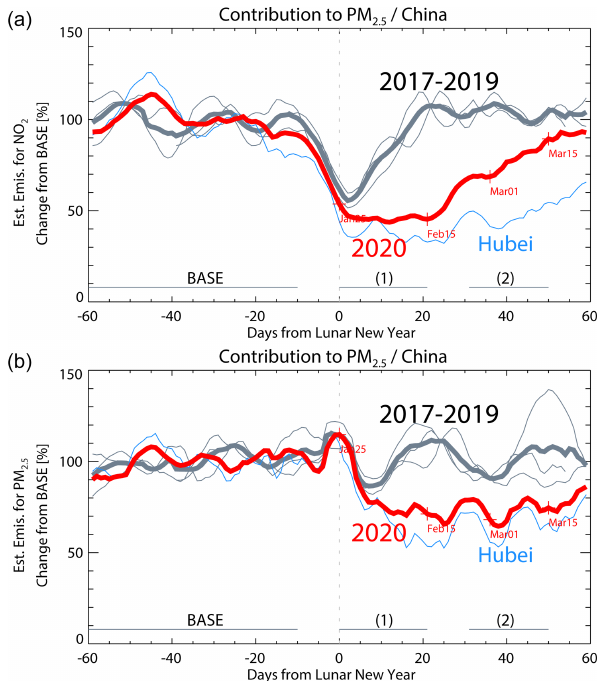
Figure 2. Time series of estimated emissions for (a) NO 2 and (b) PM 2 . 5 using 1332 surface-monitoring sites across China. The gray lines indicate 2017–2019 variations, with their average in the thick gray line, whereas the red line indicates the 2020 varia- tion. The blue line indicates the 2020 variations in Hubei Province (46 sites). BASE is used as the pre-LNY period, and (1) and (2) de- note the period of maximum impact and the recovery period, re-